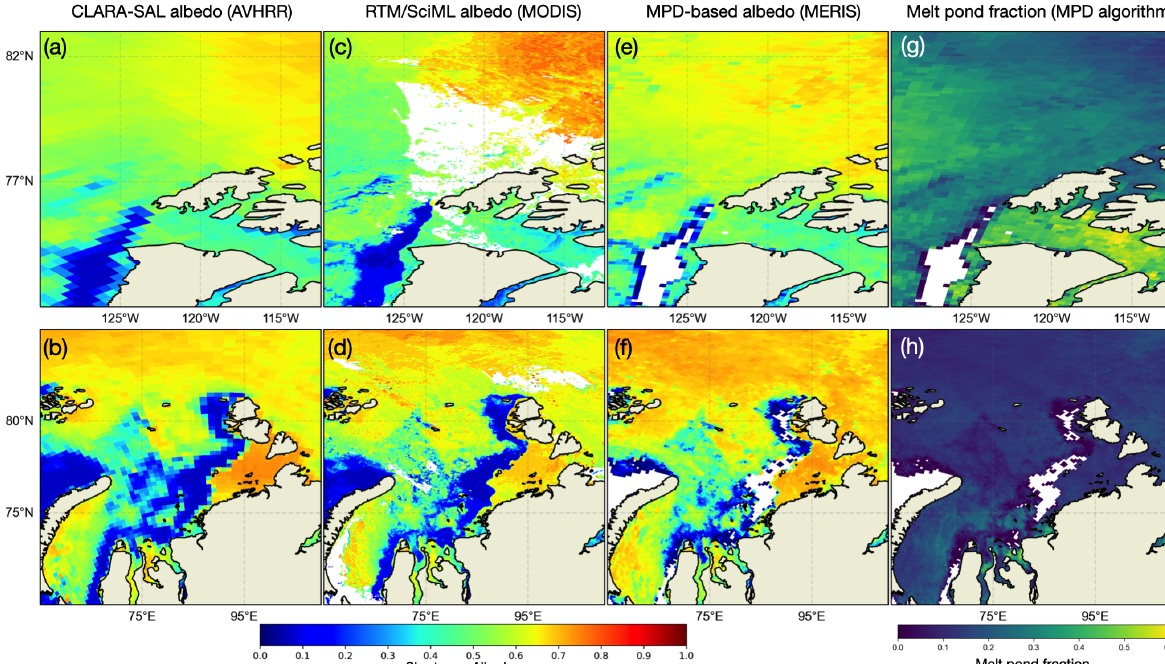
Figure 15. Maps of albedo and melt pond fraction averaged during a 5d period in 2007 between DOY 166 and 170. From left to right, the columns show CLARA-SAL albedo, RTM–SciML-based albedo retrievals, MPD-based albedo retrievals, and the MPD-derived melt pond fraction (Karlsson et al., 2012 this study, and Istomina et al., 2015). The upper panels depict the Kara Sea, while the lower panels depict Banks, Prince Patrick, and Melville islands. At the bottom, color bars representing the corresponding values are displayed. In panels (c) and (d) , empty regions represent cloud pixels that were detected by the MLCM cloud mask (and hence removed), whereas empty regions in panels (e) through (h) represent either cloud pixels or open-water areas that were not processed by the MPD